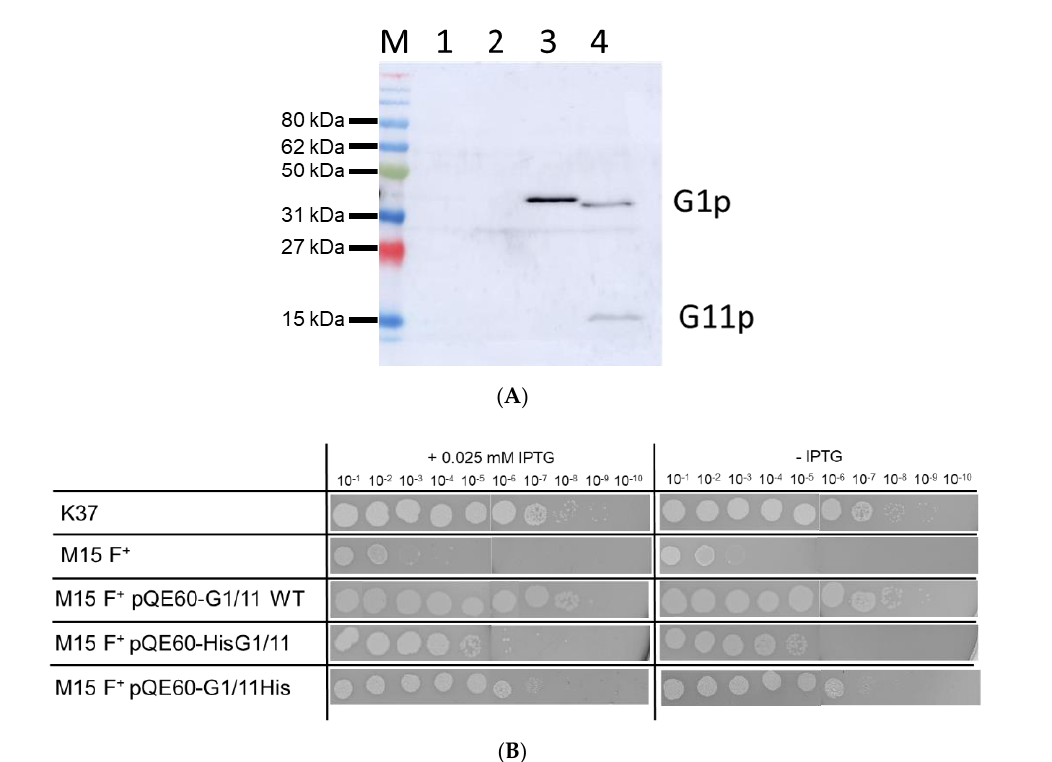
Figure 2. Expression and functionality of plasmid-encoded G1p. ( A ) The expression of the plasmid- encoded G1p was analysed in M15F+ cells by Western blot. Lane 1: empty plasmid, lane 2: G1p/G11p, lane 3: HisG1p/G11p and lane 4: G1pHis/G11pHis were expressed from the respective plasmids after induction with 0.5 mM IPTG for 1 h and processed for immunoprecipitation. ( B ) The plasmids encoding G1p and G11p were transformed into M15F+ cells and analysed for complementation of M13am1 phage propagation, either with 0.025 IPTG (left column) or no IPTG (right column). For a control, E. coli K37 (sup + ) was included in the